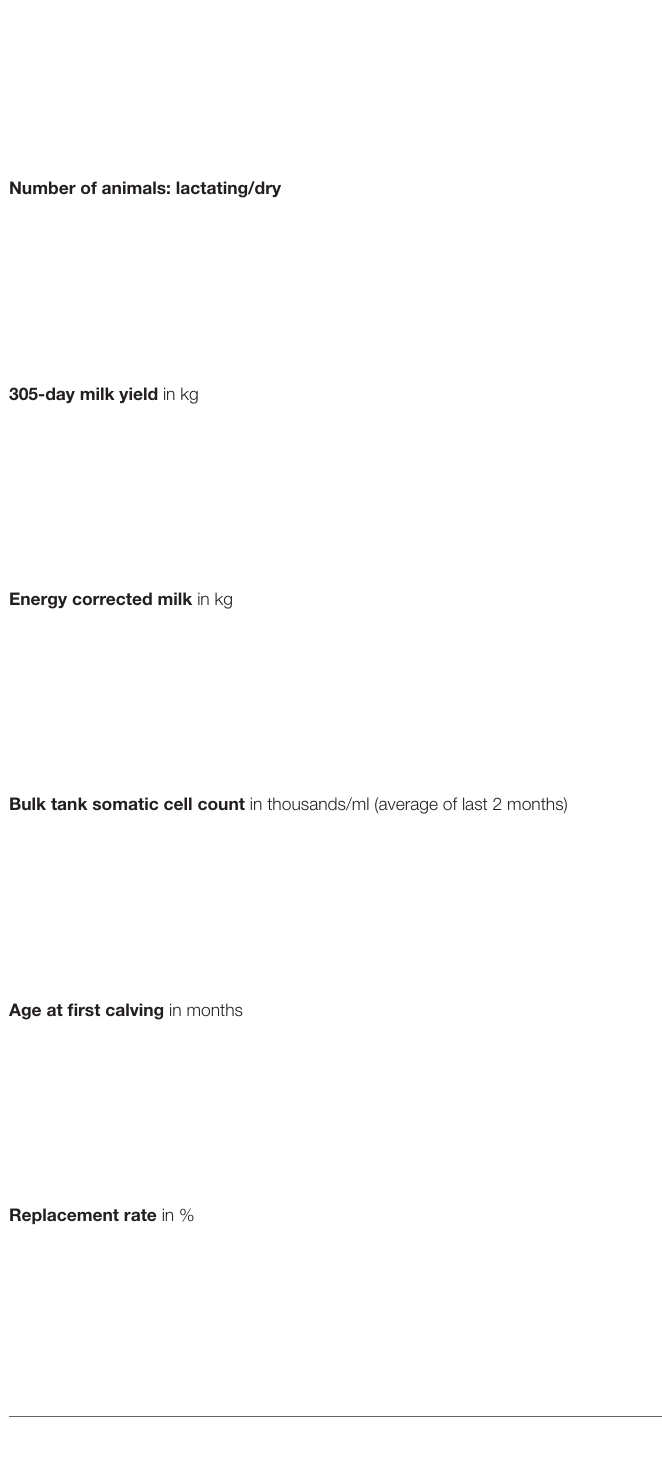
TABLE 2 | Farm characteristics. Total number of animals for milk production (incl.